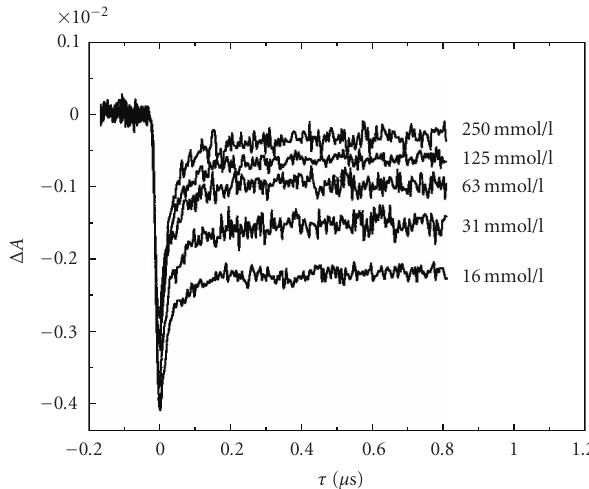
Figure 5: N3 recovery in presence of increasing concentration of NaI in